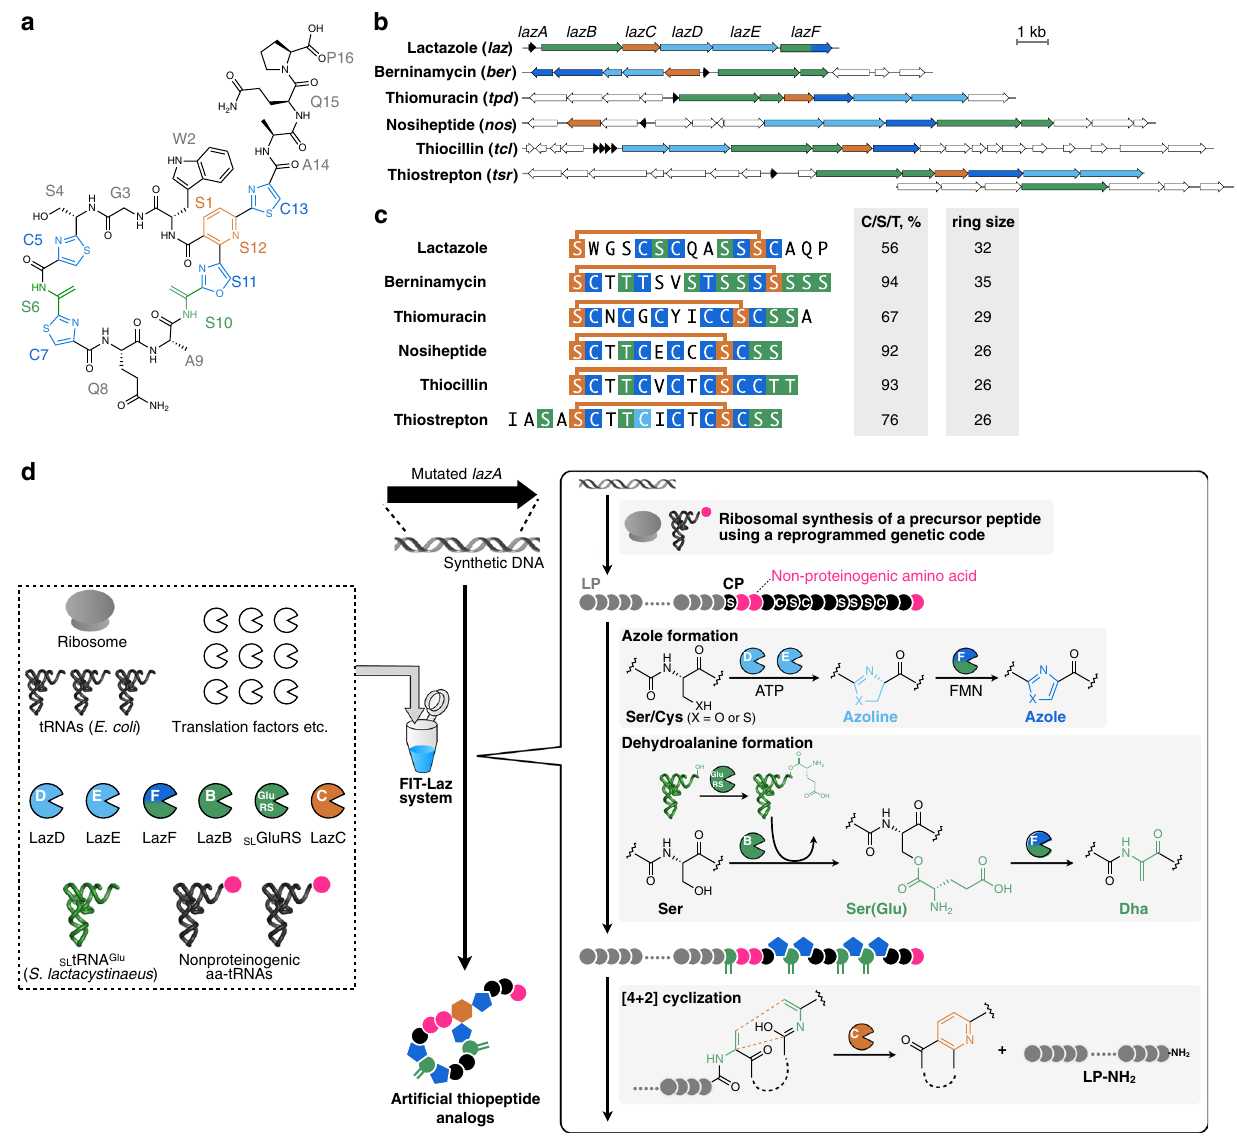
Fig. 1 Lactazole A and its biosynthesis with the FIT-Laz system. a Chemical structure of lactazole A. b Comparison of laz BGC with other prototypical thiopeptide BGCs. Homologs of laz genes are color-coded. Genes encoding enzymes responsible for the installation of azolines, azoles, dehydroalanine, and pyridine are shown in light blue, blue, green, and orange, respectively. Precursor peptide structural genes are shown in black and ancillary genes absent from laz BGC are in white. c Comparison of primary sequences for thiopeptides from b , with the same PTM color coding. The comparison reveals an unusual macrocycle size, low C/S/T content, and the absence of azole modi fi cation in position 2 as unique features of lactazole. d Summary of the FIT-Laz system and the roles of individual enzymes during lactazole biosynthesis. In FIT-Laz, synthetic DNA templates encoding LazA or its mutants are in-vitro transcribed and translated to generate precursor peptides, which undergo a cascade of PTMs introduced by lactazole biosynthetic enzymes to yield lactazole A or its arti fi cial